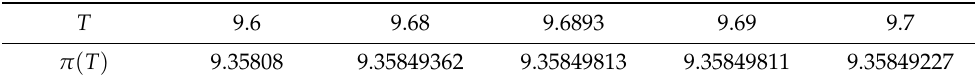
Table 5. Related profits for Example 3.